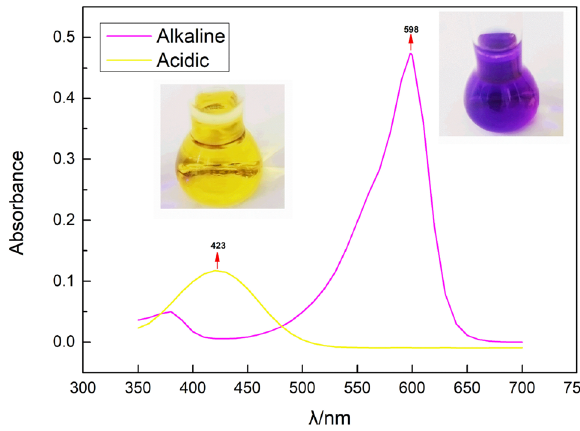
Figure 4: Absorbance spectra of BCP and color change at di ff erent